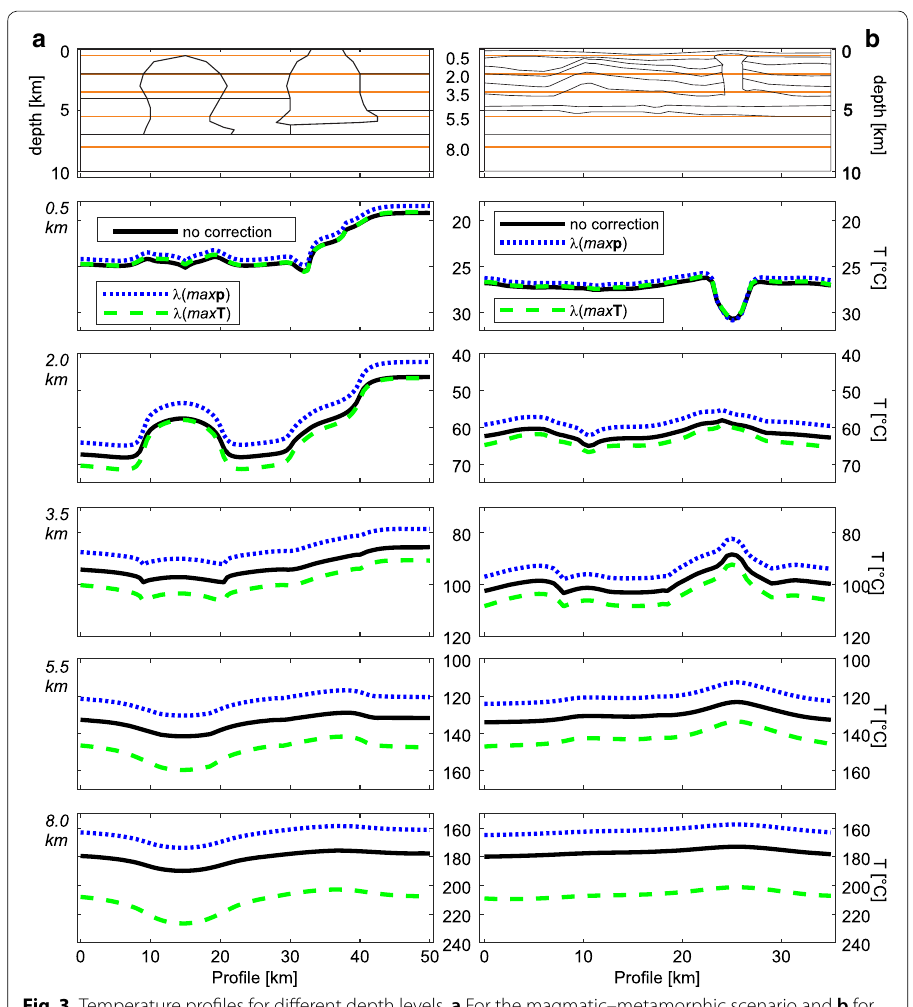
Fig. 3 Temperature profiles for different depth levels. a For the magmatic–metamorphic scenario and b for the sedimentary scenario considering the respective thermal effect (i) of a maximum pressure ( p ) correction [ λ (max p )] of the ambient thermal conductivity; (ii) of a maximum temperature ( T ) correction [ λ (max T )] of the ambient thermal conductivity, and (iii) of no correction of the ambient thermal conductivity on the respective thermal field. For data input see Table